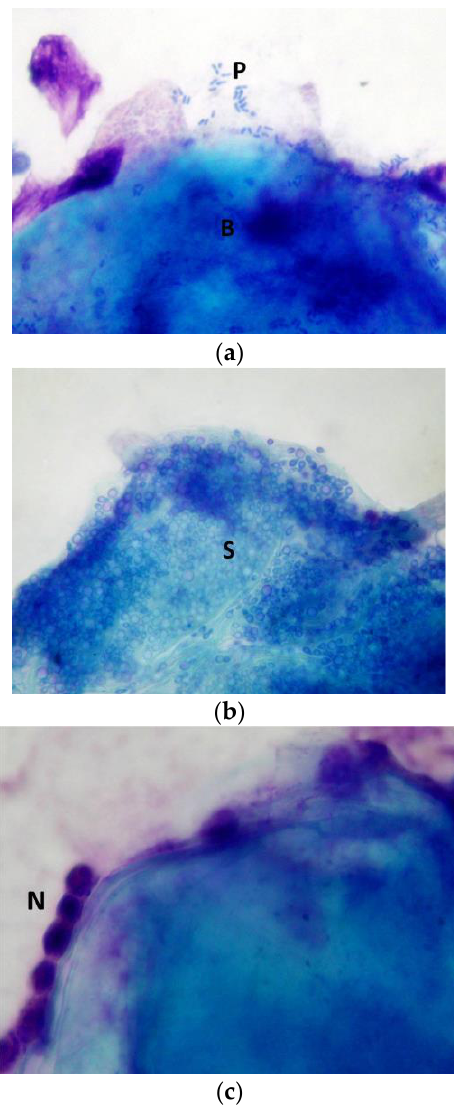
Figure 1 . ( a ) Nasal cytology: Bacterial biofilm. Characteristic is the cyan color of the biofilm. Numerous bacteria within the exopolysaccharide matrix (B); and informs planktonic (P). (May Grunwald Giemsa (MGG); 1000× magnification); ( b ) nasal cytology: mycotic biofilm. Numerous mycotic spores (S) within the exopolysaccharide matrix. (MGG; 1000× magnification); ( c ) nasal cytology: biofilm. The exopolysaccharide matrix of the biofilm represents a true barrier to neutrophils (N).